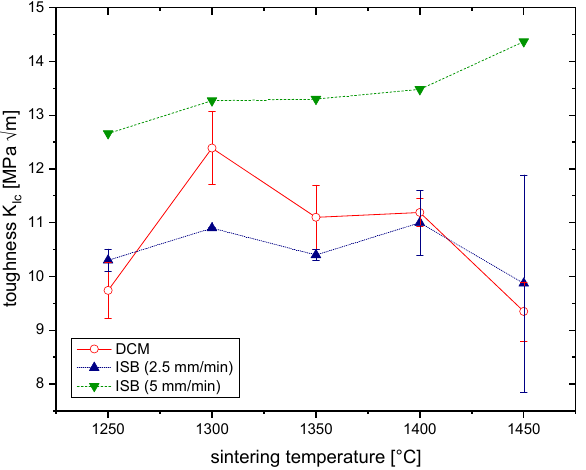
Figure 2. Fracture resistance values K DCM and K ISB of 2Y-TZP depending on sintering temperature. Toughness values in the range between 9.3–12.5 MPa √ m in general are very high compared to a standard 3Y-TZP (K IC ≈ 5 MPa √ m [1]). One would expect that toughness increases with rising